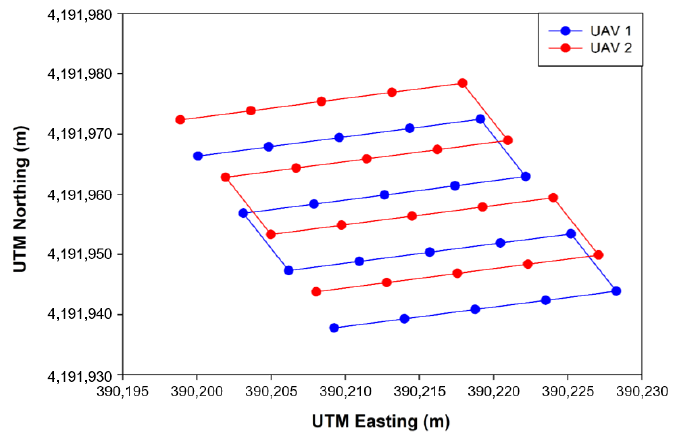
Figure 13. Multiple flight path generation obtained from the multiple-path generation algorithm.